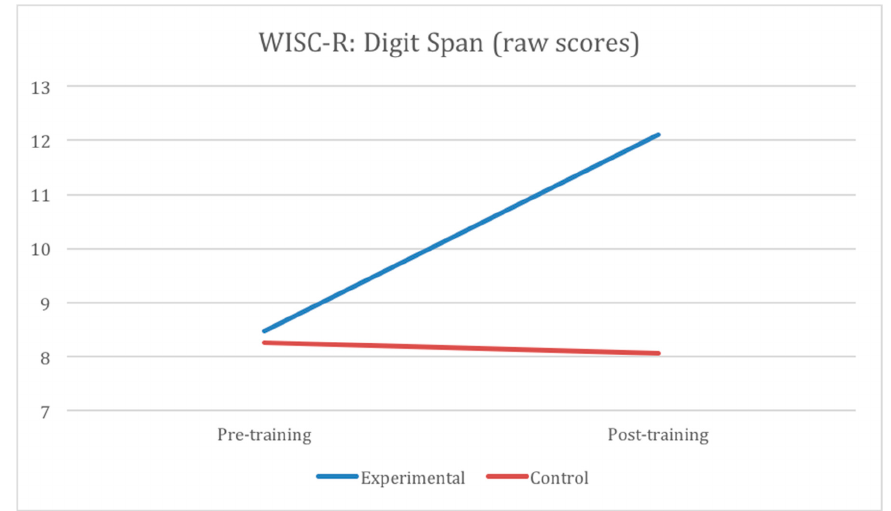
Figure 1 . Mean raw scores of the WISC-R Digit Span subtest obtained by two groups in pre-test and post-test.